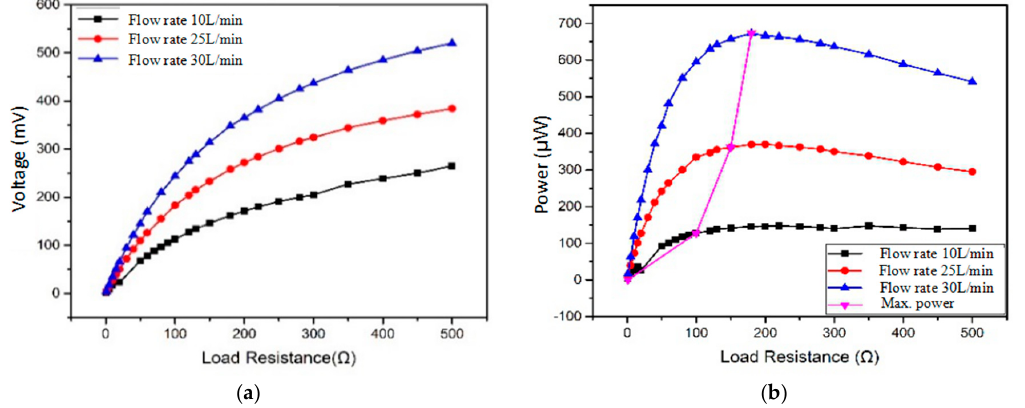
Figure 7. Open circuit voltage of EMG for single-magnet in opposite direction and double-magnet in same direction.